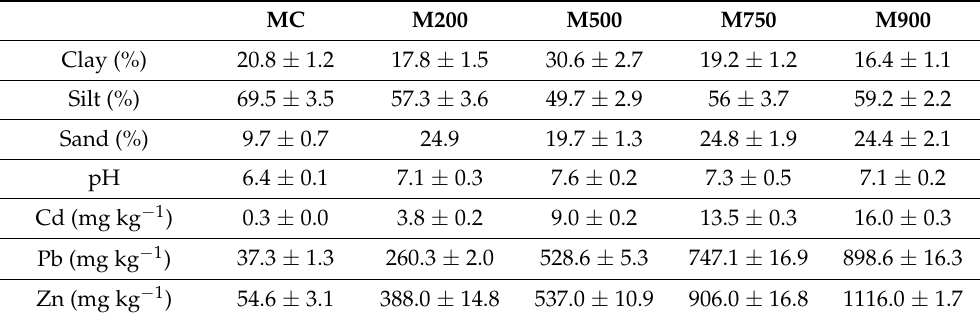
Table 1. Particle size distribution, pH, Cd, Pb and Zn concentrations of the studied soils representing gradient TE concentration (MC-control, M200, M500, M750 and M900). Values are presented as means ±